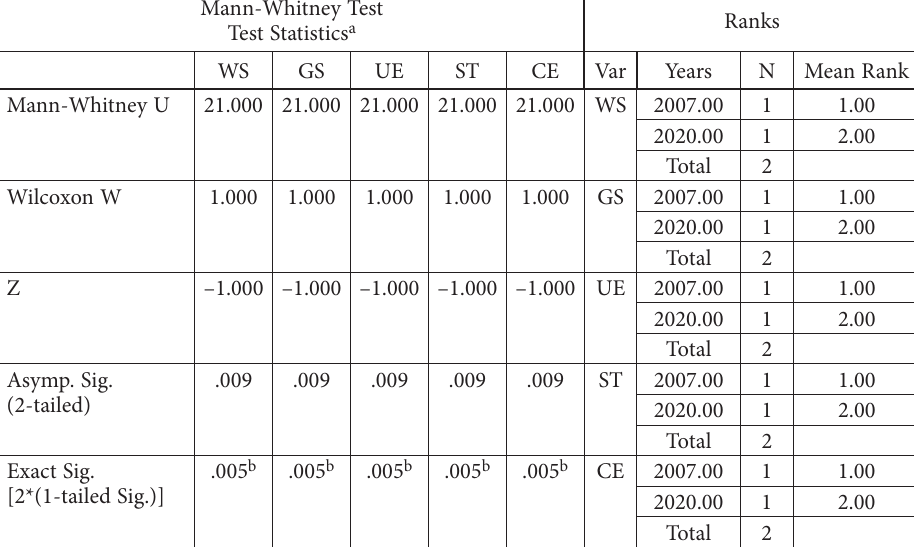
Table 7. Mann-Whitney test Mann-Whitney Test Test Statistics a